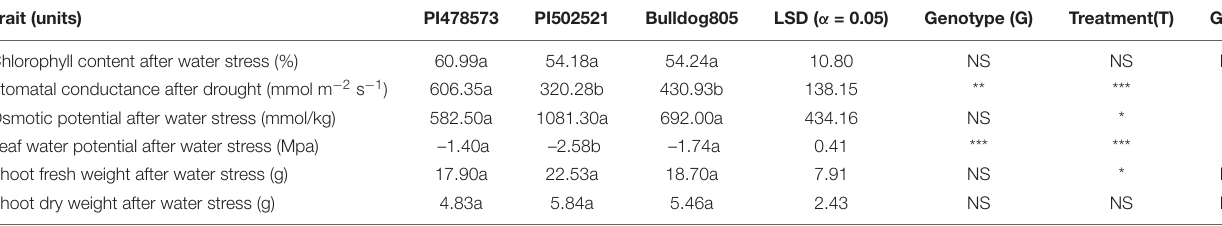
TABLE 1 | Physiological and biomass traits of the aboveground shots and root tissues from three alfalfas evaluated in Exp. 1. Trait (units)